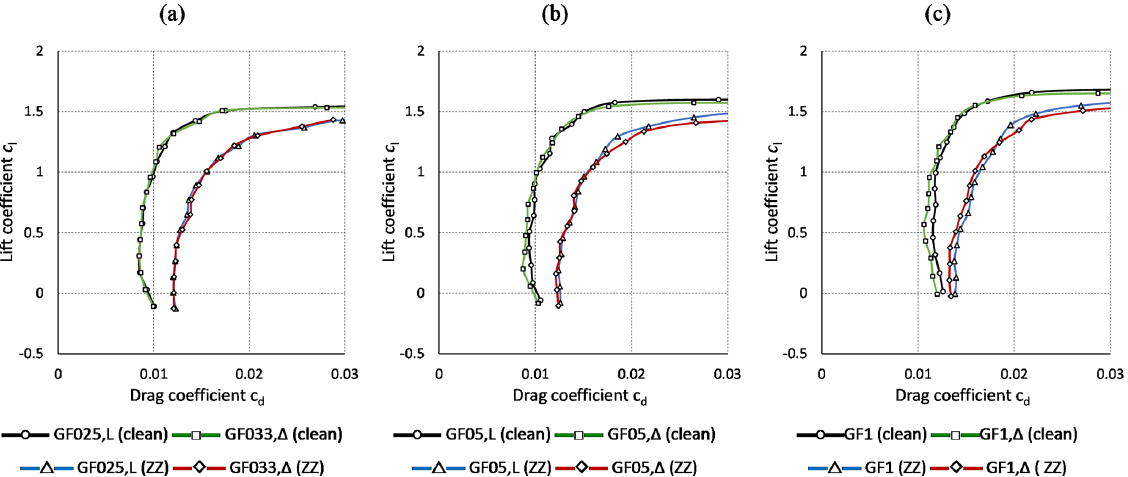
Figure B2. NACA63(3)618. Rectangular ( L ) versus triangular ( (cid:49) ) Gurney flap profiles. Lift over drag curves in clean and tripped cases (a) h MGF , L = 0 . 25% c and h MGF ,(cid:49) = 0 . 33% c . (b) h MGF = 0 . 5% c . (c) h GF = 1% c